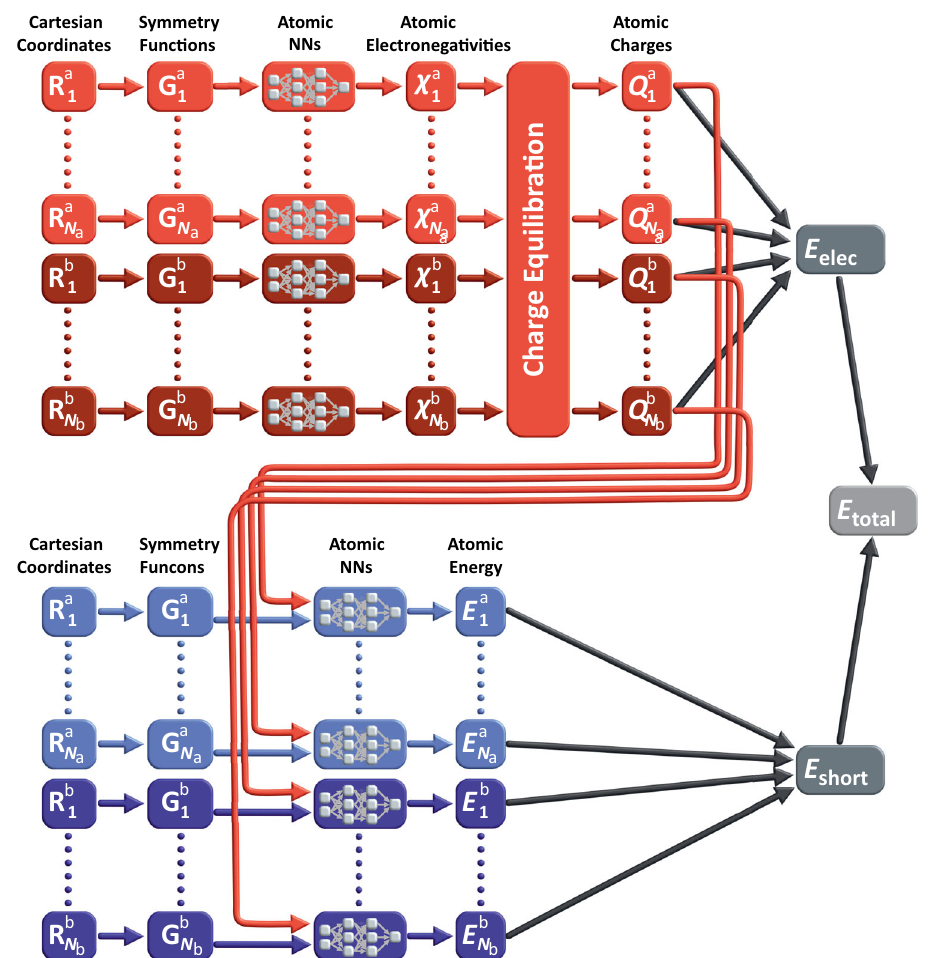
Fig. 2 Schematic structure of a 4G-HDNNP for a binary system. For a binary system containing N a atoms of element a and N b atoms of element b the total energy consists of a short-range energy E short , which is a sum of atomic energies E i , and a long-range electrostatic energy E elec computed from atomic charges Q i . The atomic charges are determined by a charge equilibration method using environment-dependent atomic electronegativies χ i expressed by atomic neural networks (red). These charges are then used to calculate the electrostatic energy and in addition serve as non-local input for the short-range atomic neural networks (blue) yielding the E i . The geometric atomic environments are described by atom-centered symmetry function vectors G i , which depend on the Cartesian coordinates R i of the atoms and serve as inputs for the atomic neural